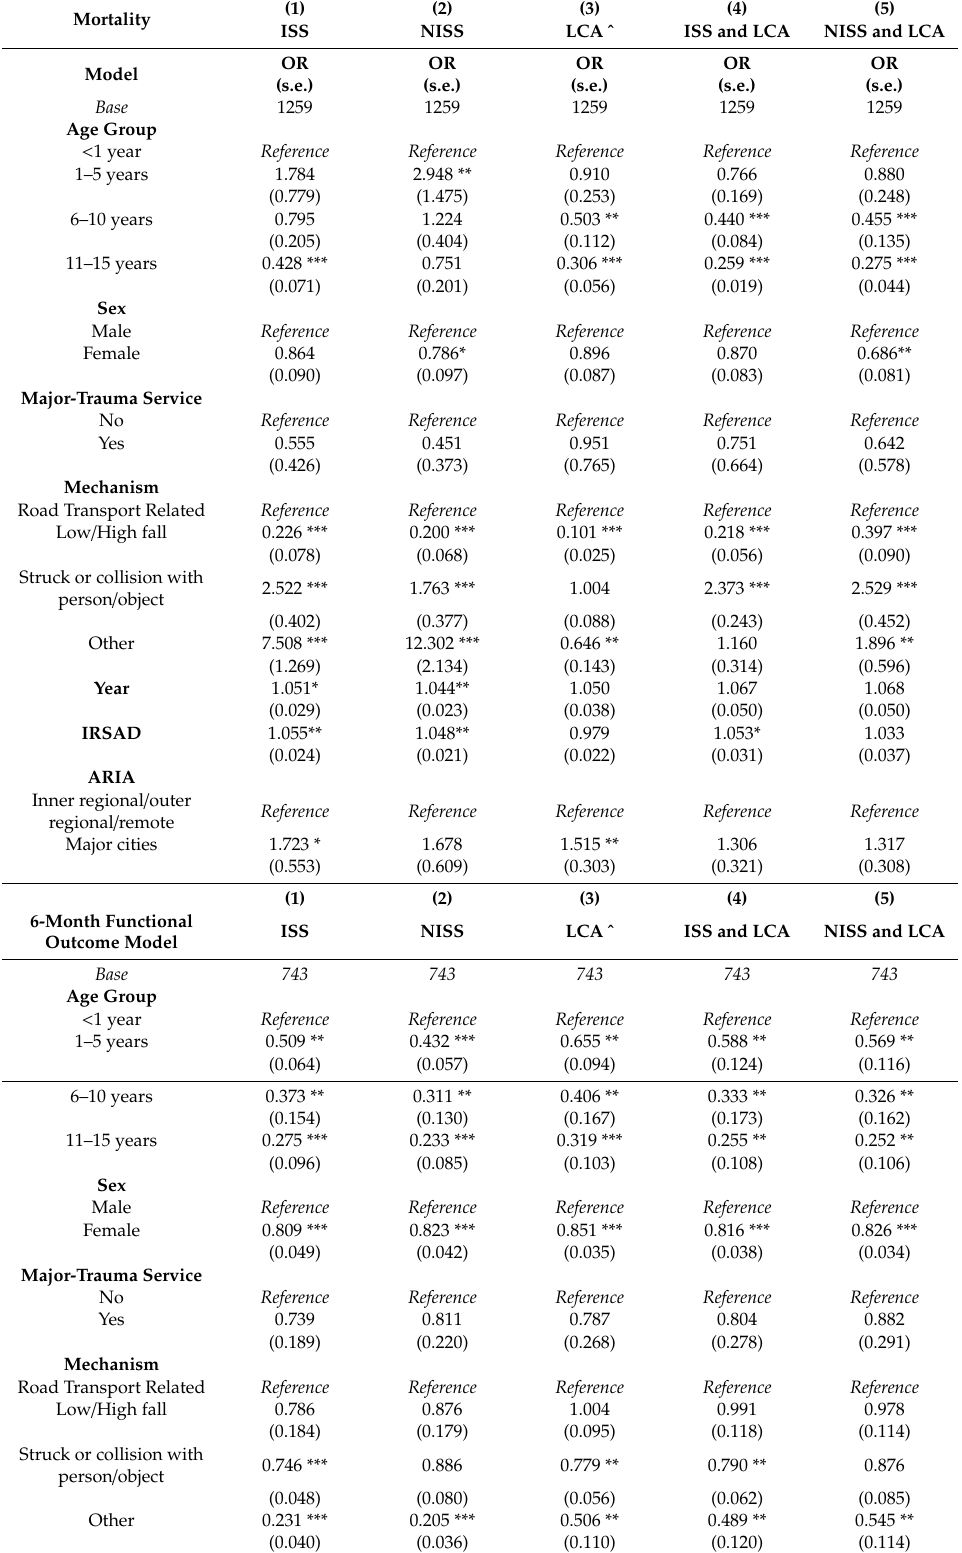
Table A1. Mortality and 6-month functional outcome logistic regression model